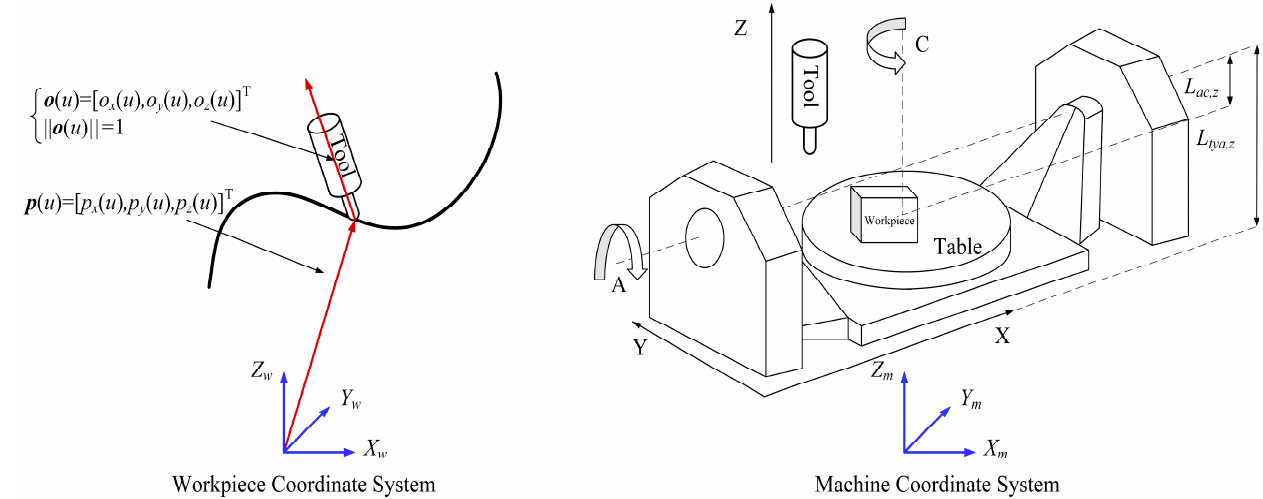
Figure 1. A–C double-turntable fi ve-axis machine tool.